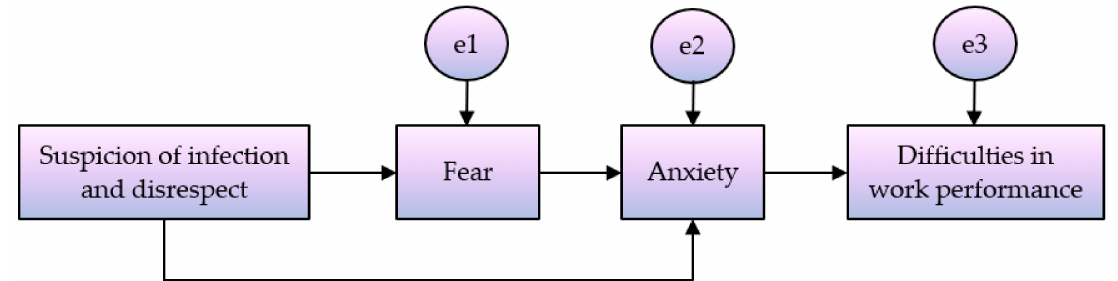
Figure 1. Conceptual framework for this